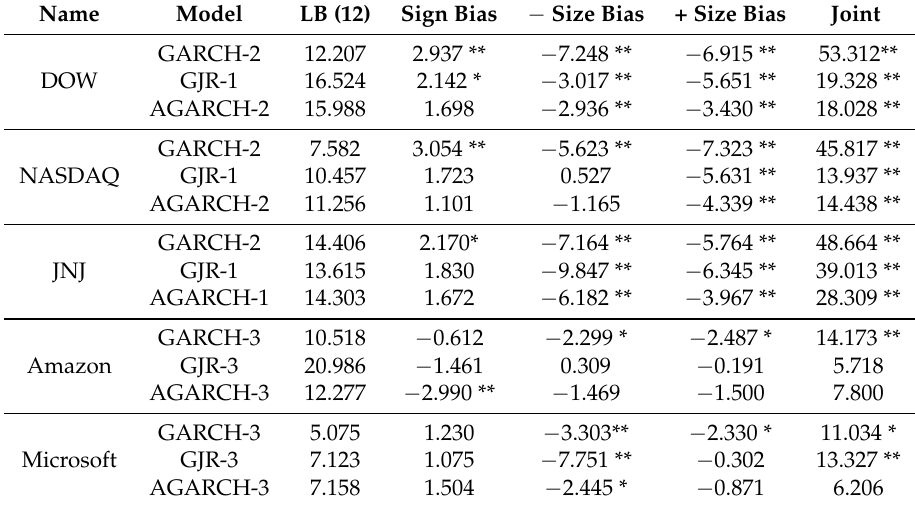
Table 8. Diagnostic Test